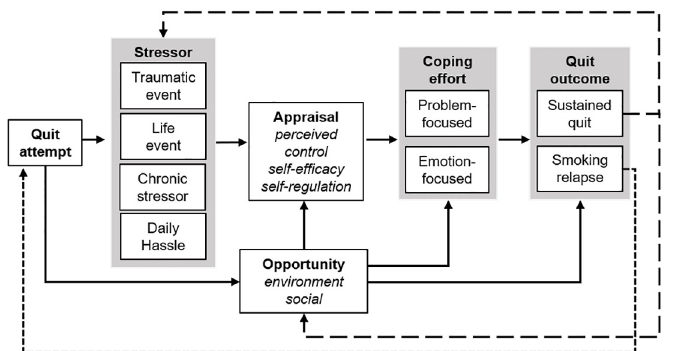
Fig 1. Simplified model of psychosocial factors predicting smoking relapse in youth experiencing